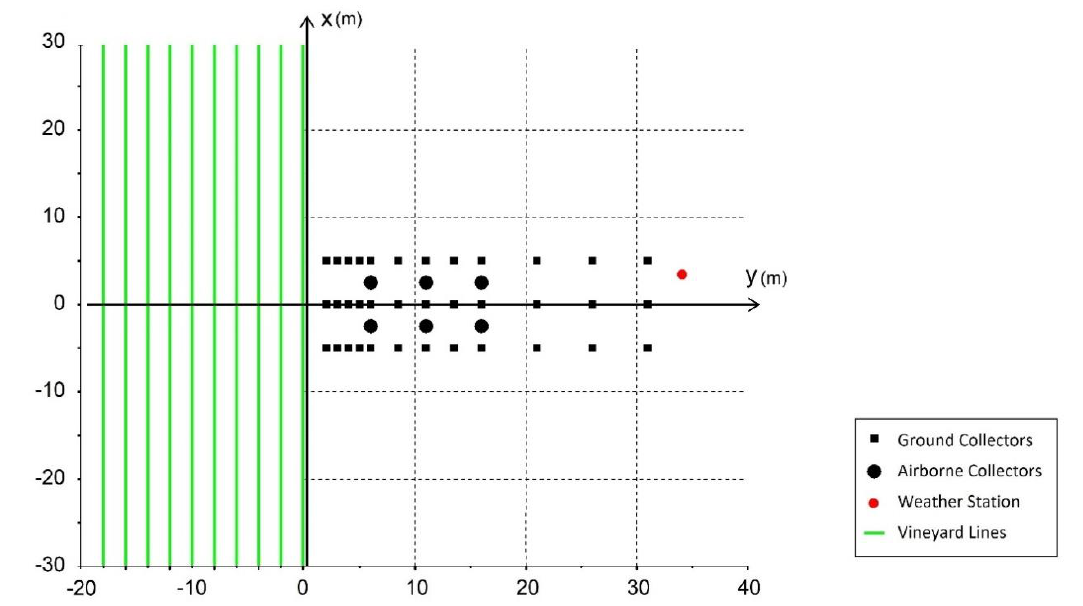
Figure 1. Test site layout according to the ISO 22866:2005 standard.